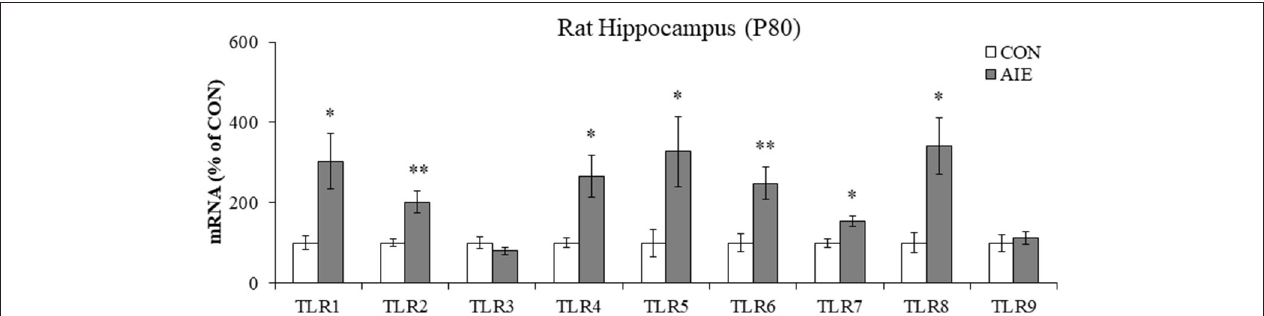
FIGURE 1 | Adolescent intermittent ethanol (AIE) treatment upregulated expression of Toll-like receptor (TLR) genes in the adult hippocampus. Quantitative PCR assessment of TLR mRNA in adult (P80) hippocampal tissue samples revealed an approximate 3-fold increase of TLR1 , TLR5 , and TLR8 , an approximate 2.5-fold increase of TLR4 and TLR6 , an approximate 2-fold increase of TLR2 , and an approximate 50% increase of TLR7 , relative to CONs. We did not observe an effect of AIE on mRNA levels of TLR3 or TLR9 . qPCR analyses were run in triplicate. Data are presented as mean ± SEM. * p < 0.05, ** p < 0.01 relative to CON.